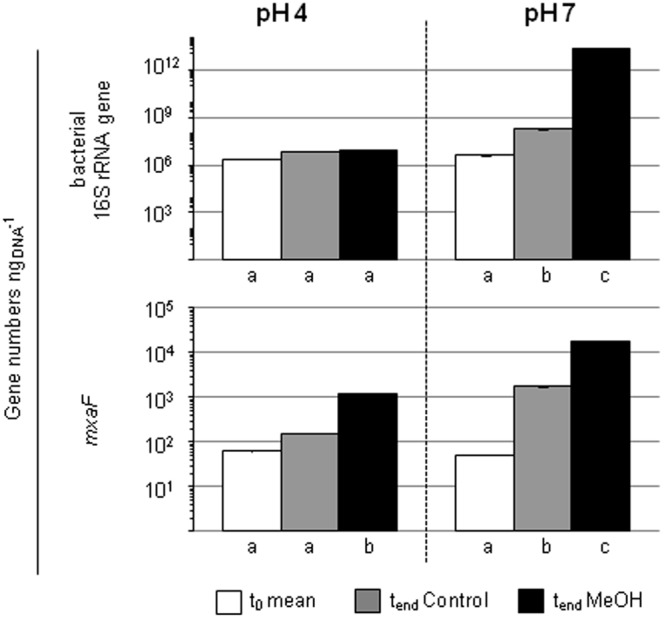
Gene numbers of 16S rRNA genes and mxaF of treatments with different pH in the pH shift SIP experiment. Columns, mean values of the experimental replicates. Error bars, standard deviation; if not visible, the variability between replicates was below 0.5%. Different letters, significant differences between samples (t-test; normal distribution was assumed based on the Shapiro-Wilk-test; n = 3).